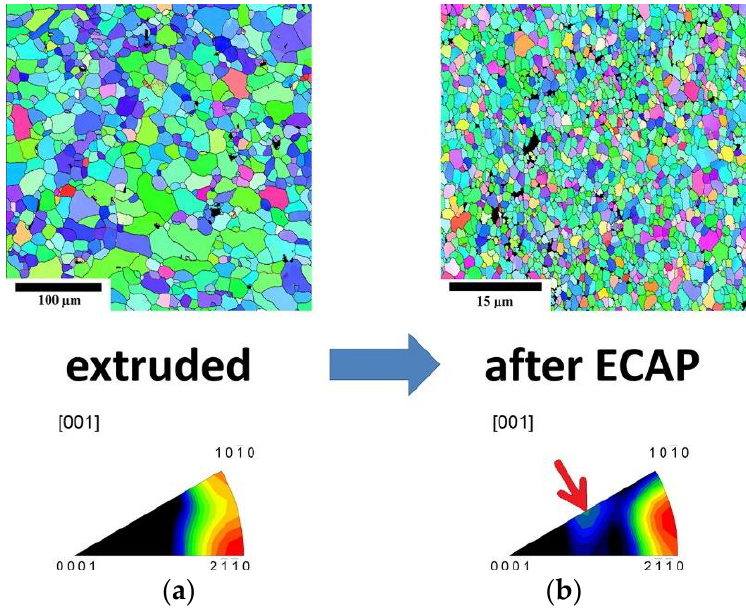
Figure 7. Electron back-scattered diffraction orientation maps of LAE442 ( a ) after extrusion and ( b ) after ECAP, with orientation triangles [146].